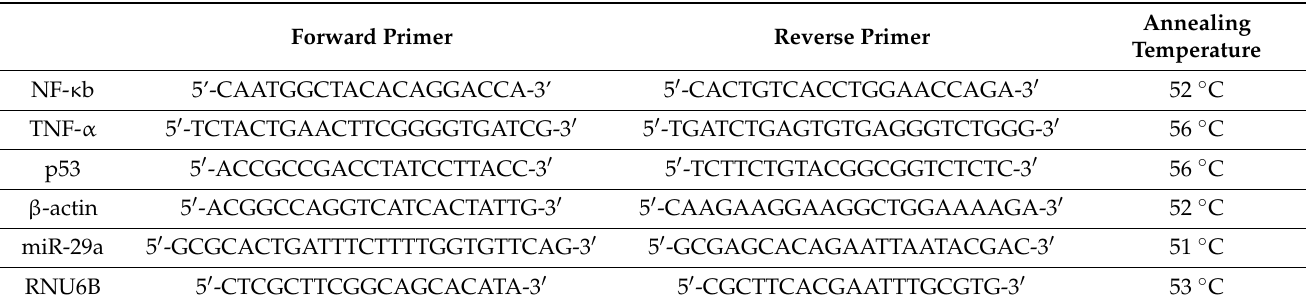
Table 1. Primer sequences and annealing temperatures for the measured